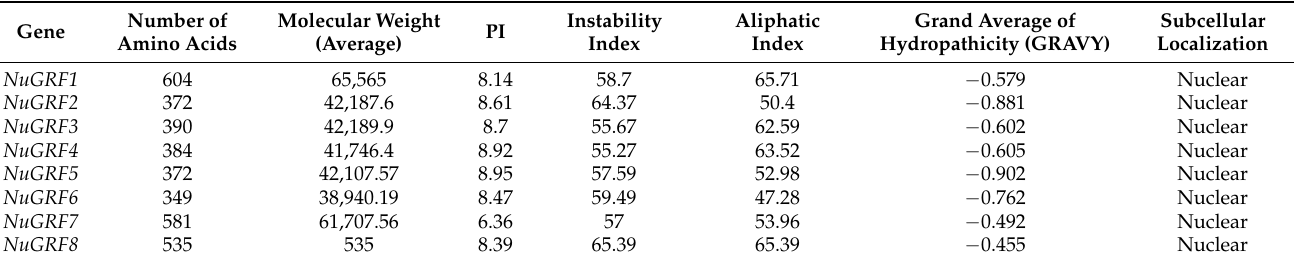
Table 1. Characteristics of the GRF genes in N. nucifera